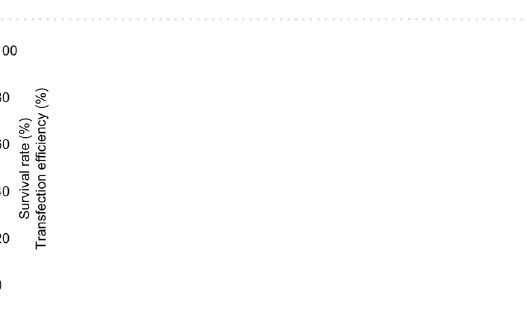
Figure 1. Overview of the earthworm tail transfection method. For easy manipulation, the transfection protocol was developed using an amputated tail fragment. A luciferase expression plasmid was injected into the amputated tail surface, and transfection success was assessed through luciferase luminescence measurements.